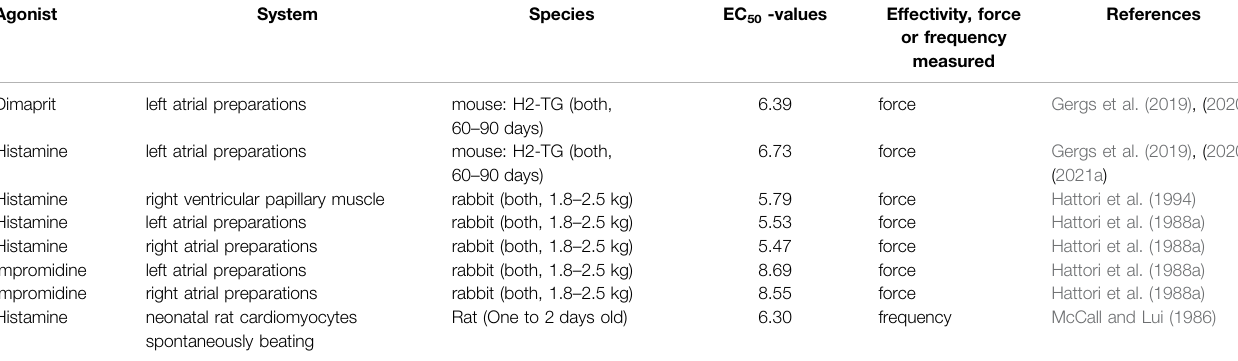
Here, some of the agonists at H 2 -histamine-receptor ( fi rst column) have been compared for their inotropic or chronotropic potencies (fourth column), the signal studied (force (cid:1) force of contraction,frequency:beatingrate: fi fthcolumn),differentiatedaccordingtoregionoftheheart(secondcolumn)andspeciesstudied(thirdcolumn)andthereferencesisgiveninthelast column.Thetableisordered fi rstlybyspeciesandthereinbyagonist.Rightatrialpreparationmeansthatinisolatedpreparationstheforceofcontractionwasmeasuredinspontaneously beatingpreparationsandtheintervalsbetweenbeatshavebeenusedbytheauthorstoassessthepotencyoftheagonistonbeatingrate( (cid:1) frequencyofbeating)andusedthistocalculate itspositivechronotropiceffect.InthepaperfromMcCallandLui(1986),movementofthewallofneonatalratcardiomyocyteswasusedtoassessthebeatingrateunderamicroscope.Left atrial preparations or left ventricular preparations (usually papillary muscle sometimes strips of ventricular walls were used) indicates that in isolated preparations the force of contraction was measured in electrically stimulated preparations and the authors used force to assess the potency of the agonist to exert a positive inotropic effect. “ Langendorff ” in the columns meansthatanisolatedspontaneouslybeatingbufferperfusedheartwasstudied(Langendorff1895).Baumannetal.(1981b)measuredwithballoonsthepressureintherightventricleas wellas theleft ventricleinisolated spontaneouslybeatingheartsaccordingtoLangendorff(1895). Inbrackets,inthe thirdcolumns “ both ” , “ male ” orfemale ” refer to genderofpatientsor animalsand “ g ” tobodyweightingramsinanimals.Ifdataarelackinginbrackets,nodatatogenderorageorweightwerefoundintheoriginalpublication.n.d.indicatesthatthevaluewas notdocumented,forinstance,becausenotenoughagonistintheconcentrationresponsecurvewasusedtoreachsaturationoftheeffects( (cid:1) noplateaureached).Iffordrugthatactsona histaminereceptor,thereisadded “ fullagonist ” or “ partialagonist ” :thismeansthatinthatstudythedrugwasaseffectiveashistamine(fullagonist)orlesseffectivethanhistamine(partial